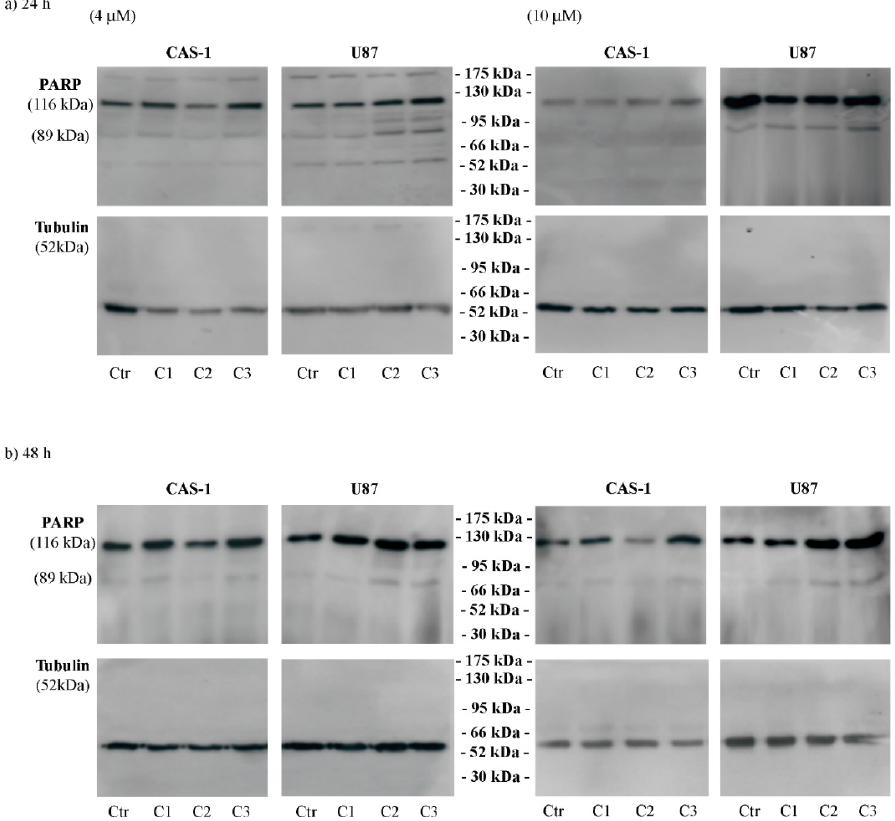
Figure 4. C2 and C3 induce apoptotic death of U87 cells. The expression levels of full length (116 kDa) and cleaved (89 kDa) PARP were evaluated in CAS ‐ 1 (left panels) and U87 (right panels) cells exposed to 4 μ M and 10 μ M of compound 1 (SI306, C1), compound 2 (C2), and compound 3 (C3) for 24 h ( a ) and 48 h ( b ). Immunoblots shown are representative of three independent experiments. Tubulin is the internal loading